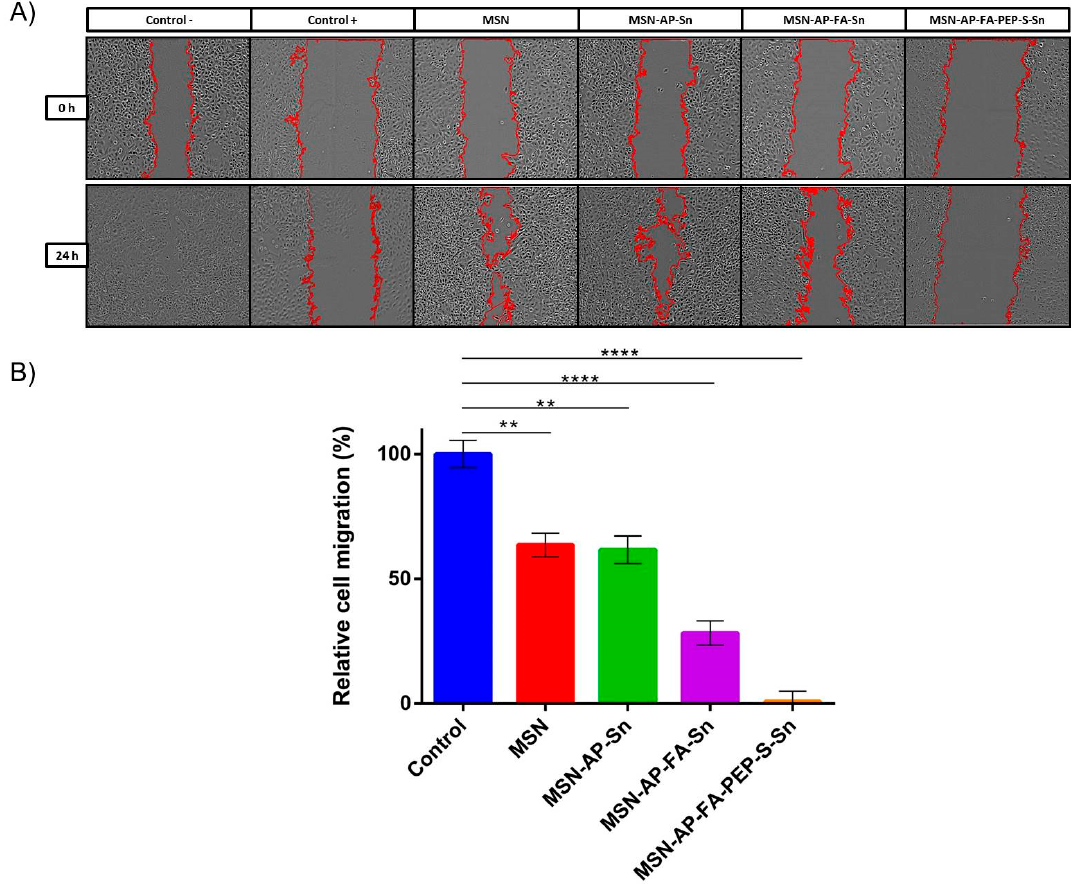
Figure 7. Wound healing assay of MDA-MB-231 cells incubated with the MSN nanoparticles. ( A ) Phase contrast microscopy images of wells. The edges of the scar are marked in red. Positive control (control + ): cells incubated with DMSO (complete migration inhibition); negative control (control − ): cells grown in culture media (complete migration and wound healing). ( B ) Quantification of cell migration. The results were expressed as % of the initial scar area (mean ± SD, n = 2 independent experiments and 2 replicates / experiment) . Significance was calculated by unpaired t-test of one-way ANOVA. **: p < 0.01 or significant statistical di ff erence between the two groups of data; ****: p < 0.0001 or highly significant statistical di ff erence between the two groups of data.